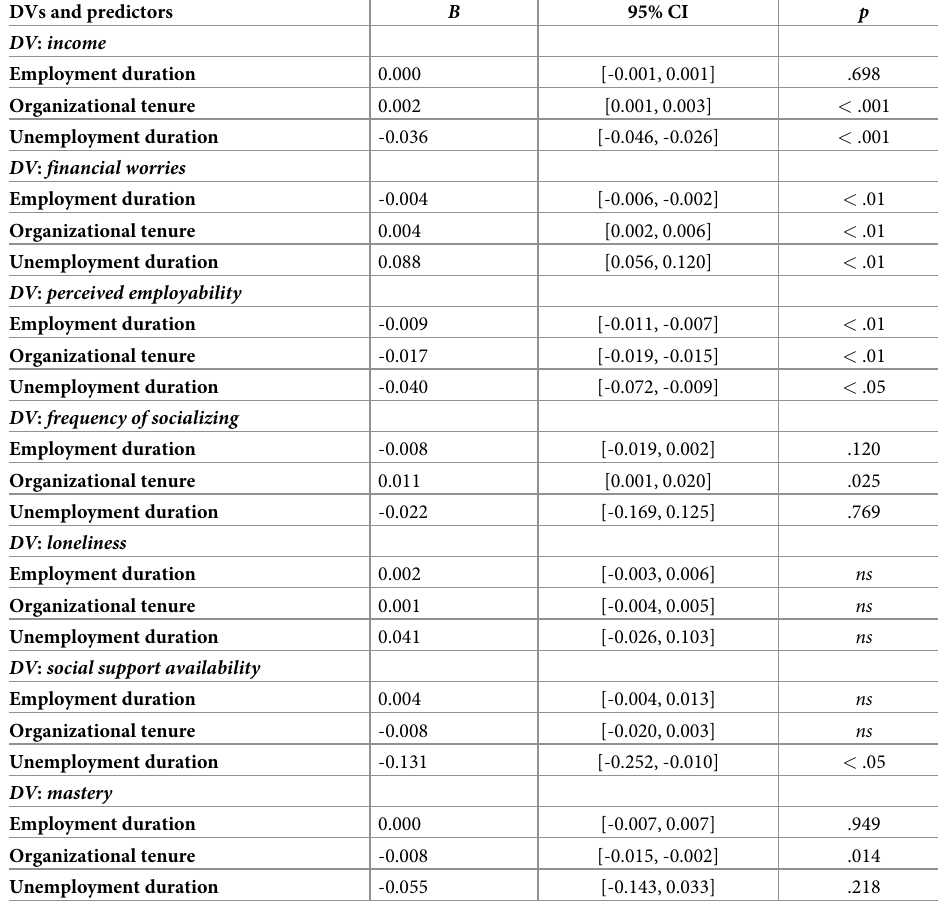
Table 2. Within-level effects of employment status duration on resources (first stage of